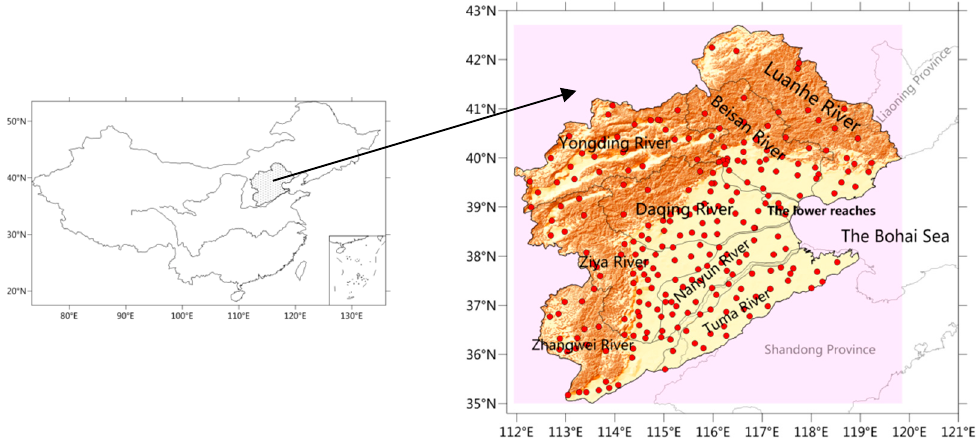
Figure 1. The geographical location and meteorological station distribution of the Haihe River basin (dots indicate locations of meteorological stations, and the purple color shows the mountains and plateaus).